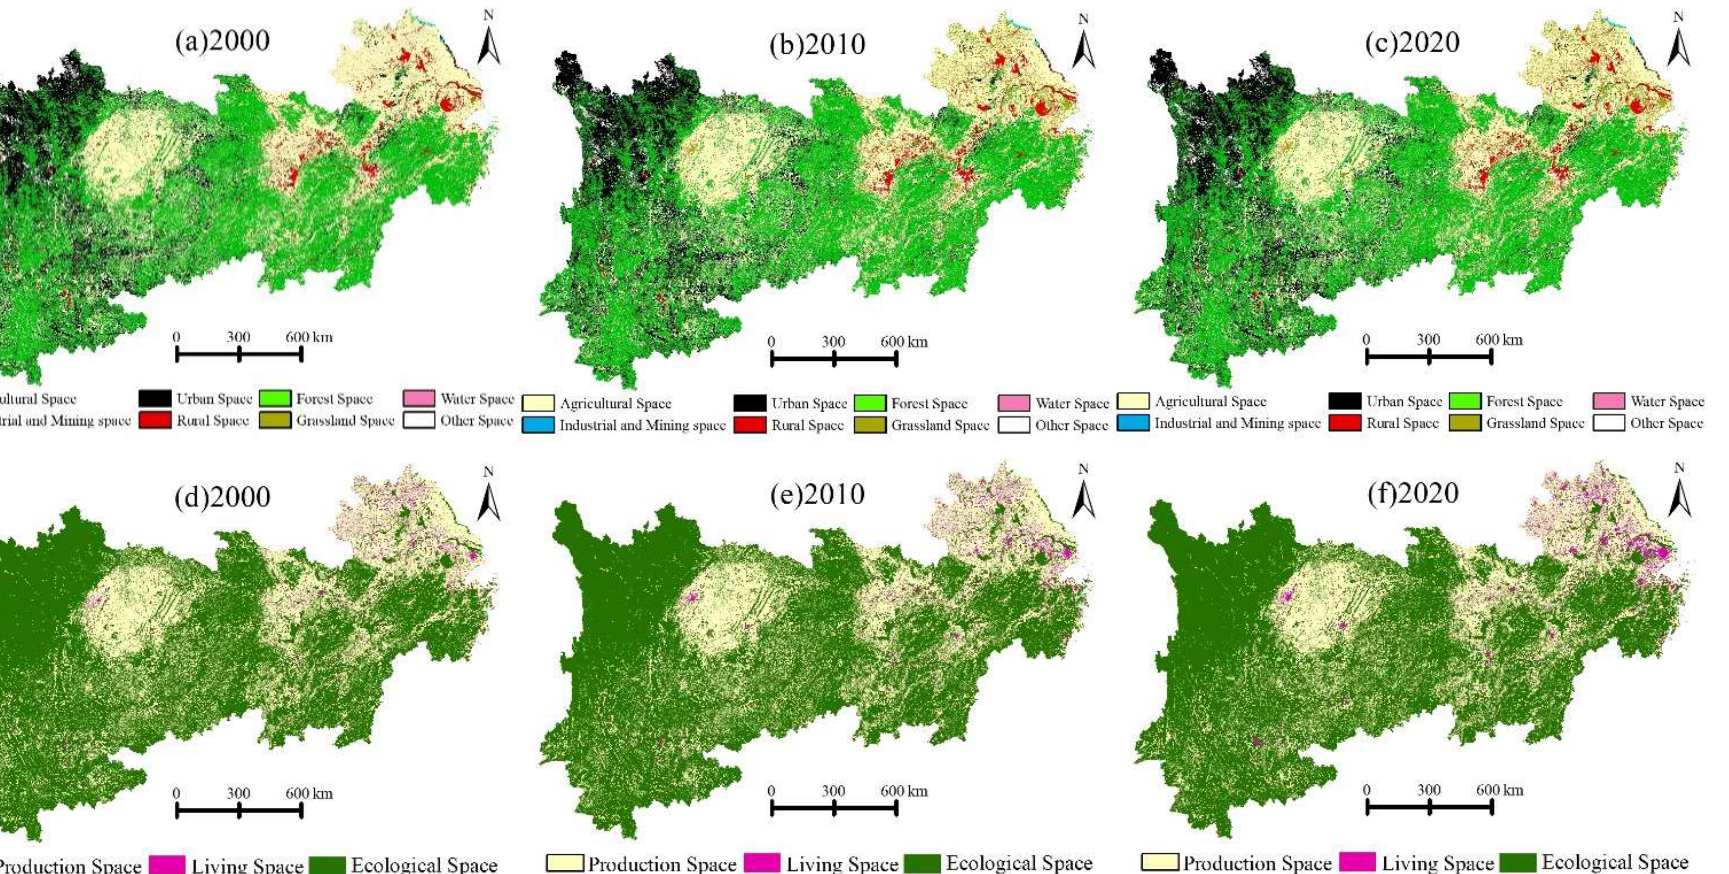
Figure 10. Evolution of the territorial space pattern of the Yangtze River Economic Belt from 2000 to 2020. ( a – c ) are the spatial distribution of agricultural production space, industrial and mining production space, urban living space, rural living space, forestland ecological space, grassland ecological space, water ecological and other ecological spaces in the Yangtze River Economic Belt in the years 2000, 2010 and 2020, respectively. ( d – f ) are the distribution of production, living and ecological space in the Yangtze River Economic Zone in 2000, 2010 and 2020,